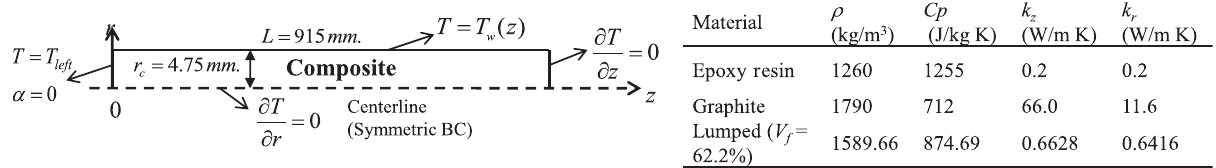
Figure 2 Schematic view of the pultrusion model of the composite rod and the corresponding boundary conditions (left). Material proper- ties of the composite rod